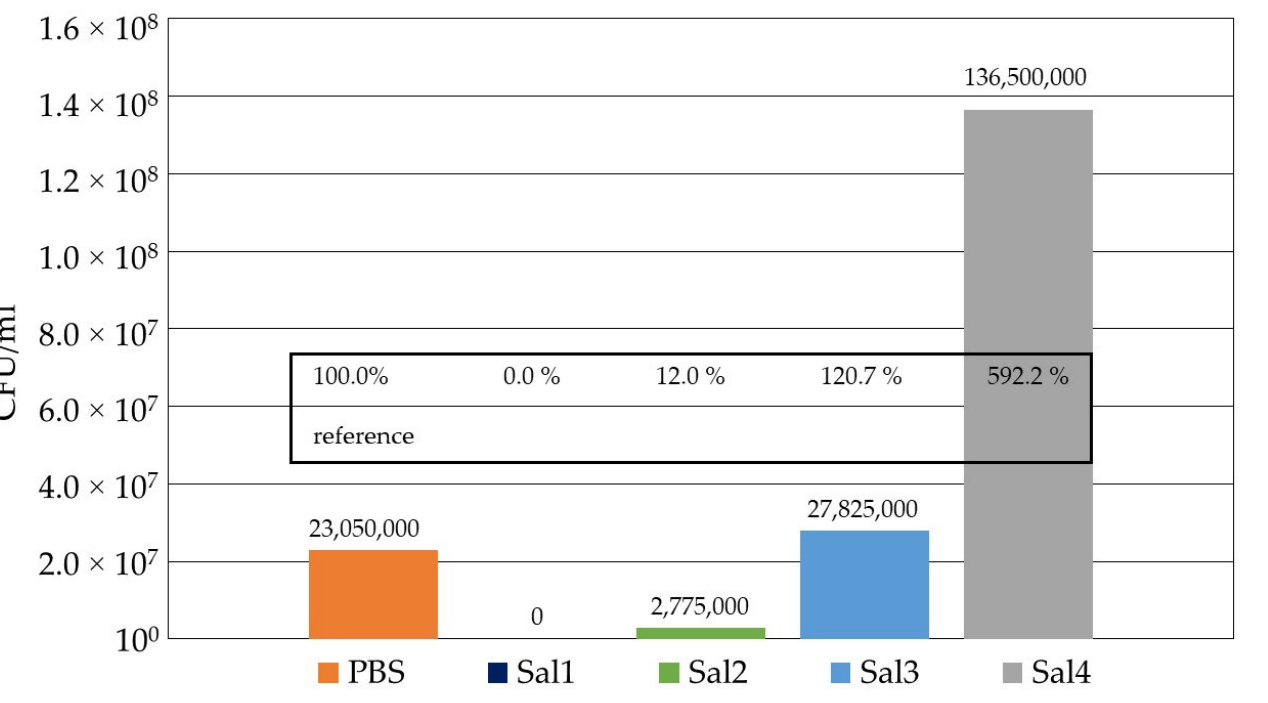
Figure 3. Comparison of the influence of the four selected artificial saliva substitutes on S. carnosus after 9 h at 37 °C compared to the control with S. carnosus in PBS.